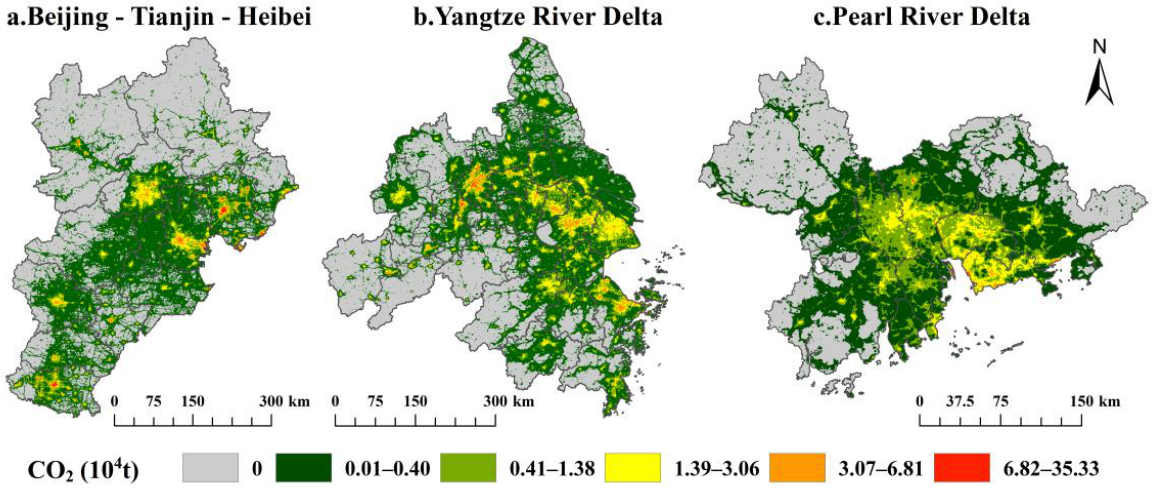
Figure 4. Spatial distribution of annual CO 2 emissions in three urban agglomerations averaged from 2014 to 2019.